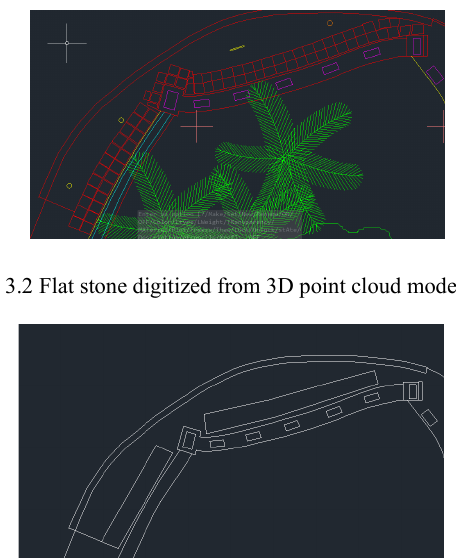
Figure 3.3 Flat stone digitized from historical google based map